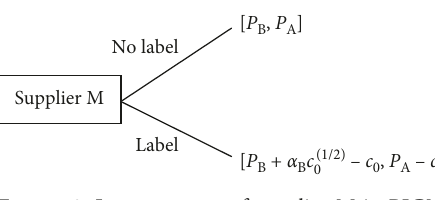
Figure 3: Income range of supplier M in BIGM. Table 1: Supplier’s optimal decision in BIGM. Condition